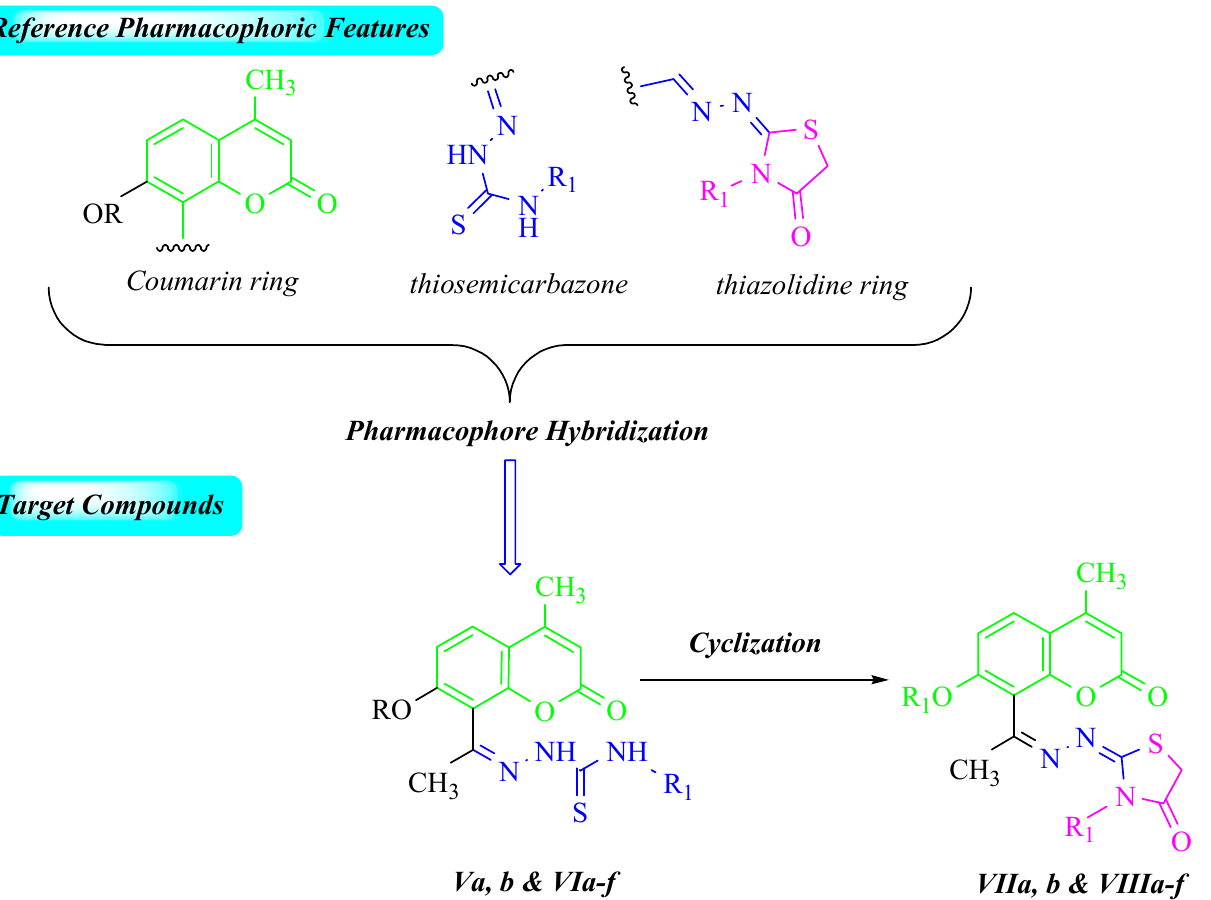
Figure 3. Design of the new compounds ( V–VIII ).